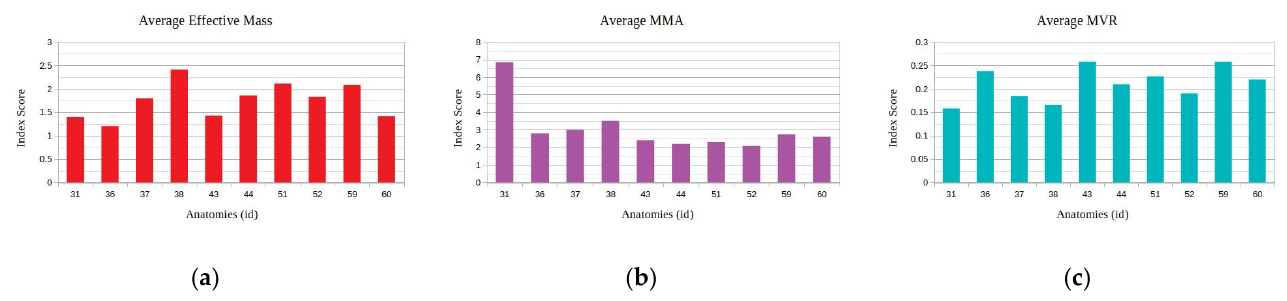
Figure 7. Derived mean index value for the selected performance indices under the available metamorphic structure anatomies, for Task 1 (( a ) with respect to the Average Effective mass index, ( b ) with respect to the Average MMA index and ( c ) with respect to the average MVR index). The y -axis in all graphs represents the value of the according index.